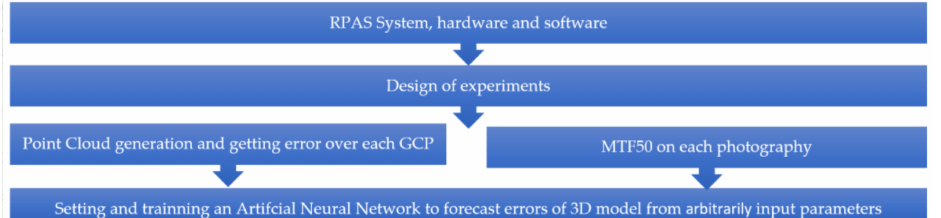
Figure 1. Research workflow. RPAS, remotely piloted aircraft systems; GCP, ground control point; MTF50, modulation transfer function